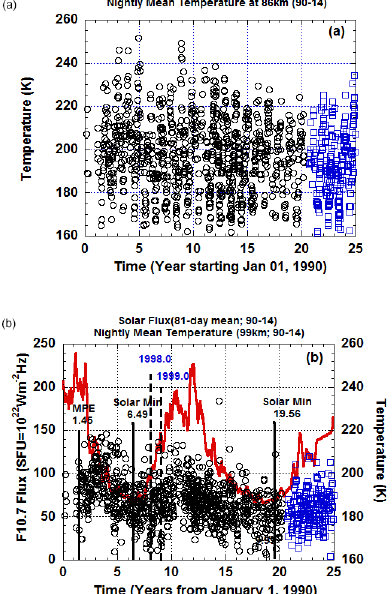
Figure 1. Time series of nocturnal mean temperature recorded by a Na lidar at 86km (a) and at 99km (b) . Included in (b) is also 81-day F10.7 solar flux in red with the times for Mount Pinatubo eruption (MPE), t MPE , and solar minima (Solar Min) marked. Data (black circles) between March 1990 and March 2010 were ac- quired at CSU (41 ◦ N, 105 ◦ W), and those (blue circles) between September 2010 and December 2014 were acquired at USU (42 ◦ N, 112 ◦